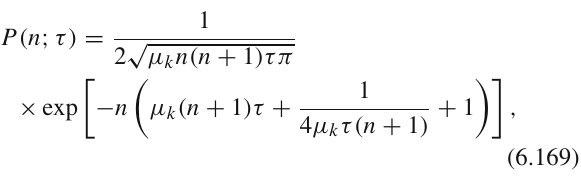
Fig. 38 Evolution of the first order contribution to the probability density function with respect to the occupation number per mode n k , for a fixed time